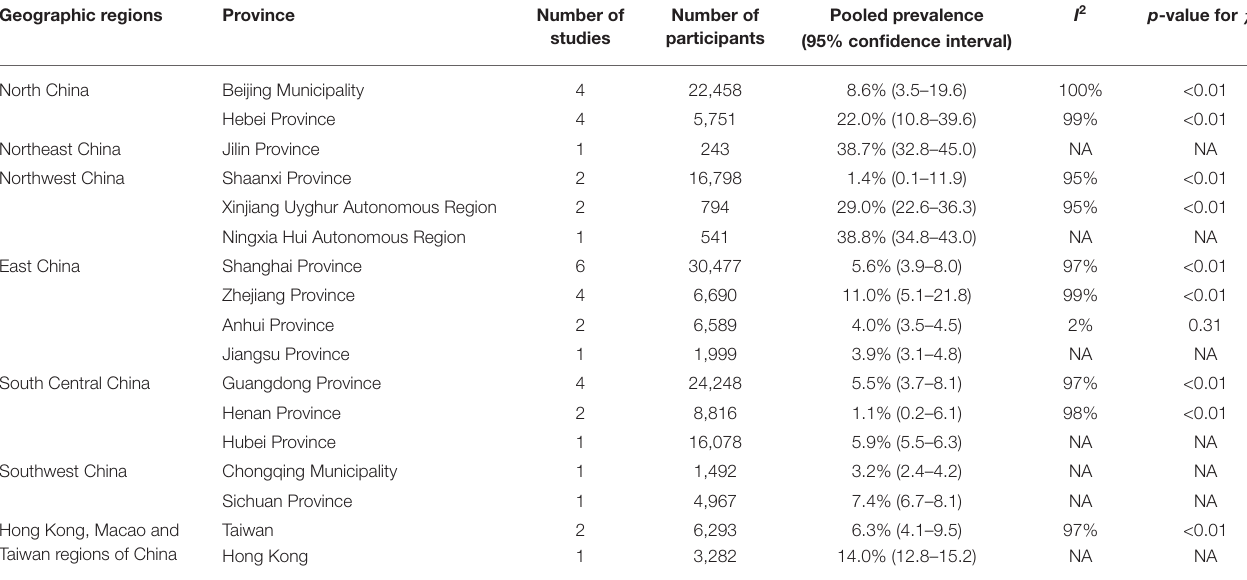
TABLE 2 | Pooled prevalence of functional constipation according to the geographic regions in China. Geographic regions